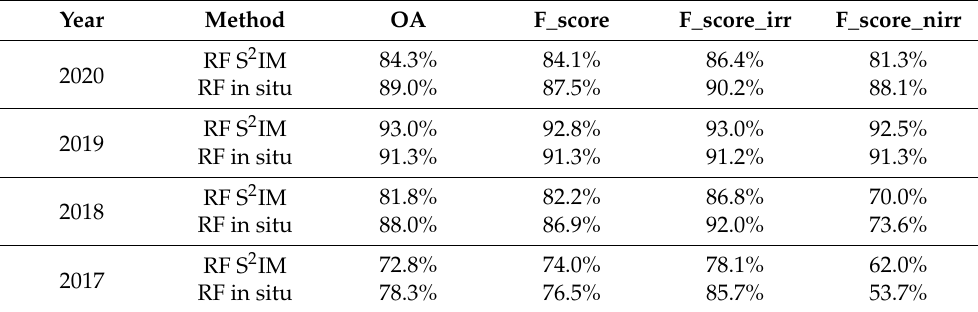
Table 3. Accuracy metrics of RF classifications obtained using the proposed S 2 IM methodology and the in situ 5-fold cross validation for four